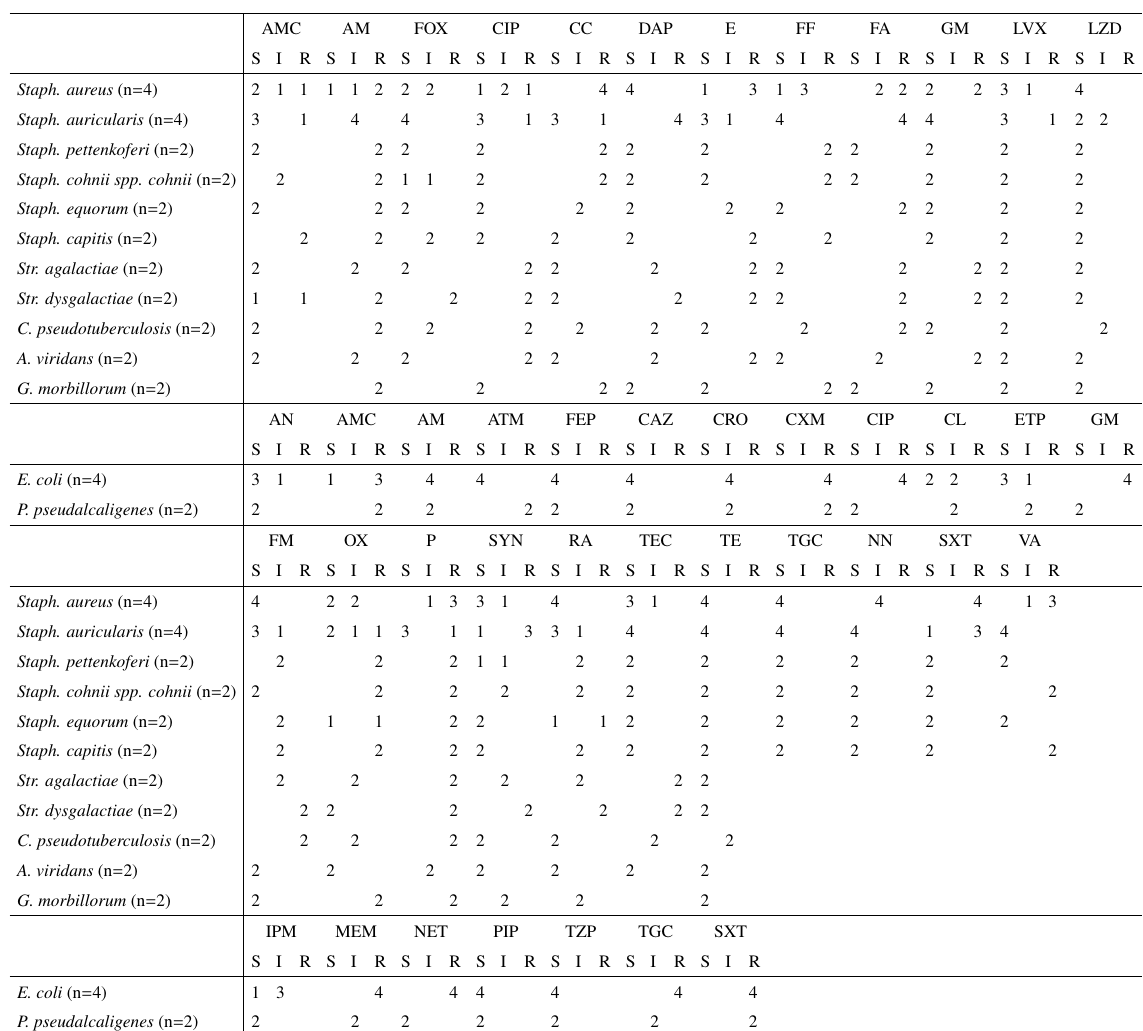
Table 3. Antibacterial susceptibility results of identified bacterial strains according to MIC values. AMC: Amoxicillin-Clavulanic acid, AM: Ampicillin, FOX: Cefoxitin, CIP: Ciprofloxacin, CC: Clindamycin, DAP: Daptomycin, E: Erythromycin, FF: Fosfomycin, FA: Fusidic acid, GM: Gentamycin, LVX: Levofloxacin, LZD:Linezolid, FM:Nitrofurantoin, OX: Oxacillin, P: Penicillin G, SYN: Quinupristin-dalfopristin, RA: Rifampin, TEC: Teicoplanin, TE: Tetracycline, NN: Tobramycin, SXT: Trimethoprim-Sulfomethoxazole, VA:Vancomycin, AN:Amikacin, ATM: Aztreonam, FEP: Cefepime, CAZ: Ceftazidime, CRO: Ceftriax- one, CXM: Cefuroxime, CL:Colistin, ETP:Ertapenem, IPM:Imipenem, MEM: Meropenem, NET:Netilmicin, PIP:Piperacillin, TZP: Piperacillin-Tazobactam,